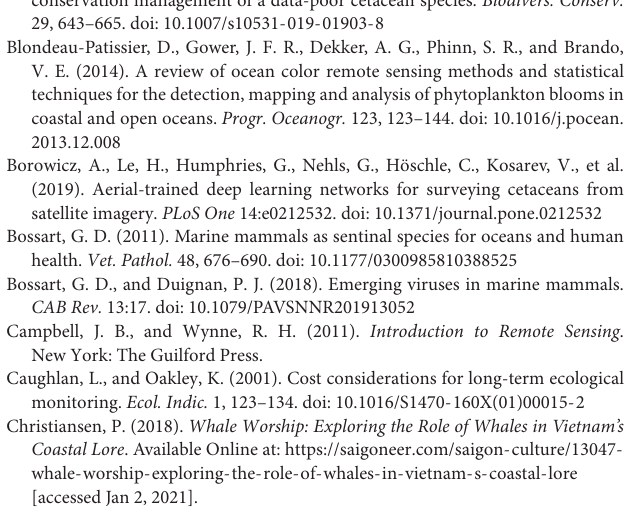
Supplementary Figure 2 | A map showing current GDP US$ (millions) for all countries and economies (GDP data accessed from the World Bank using: